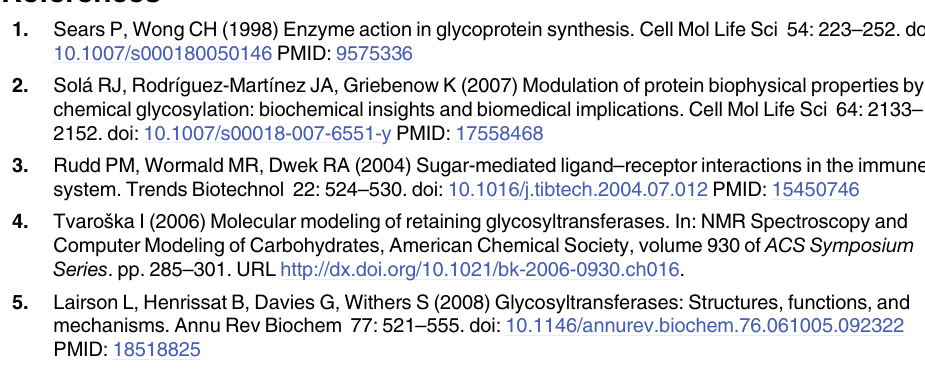
S5 Fig. Raw data points obtained by scanning the two distance-difference coordinates. Twelve outlying points (crossed out) were not used for visualisation of the total energy surface in order to obtain physically meaningful contour lines. S6 Fig. QM and MM energy components of the 2D PES scan surface obtained using dis- tance differences. S7 Fig. QM and MM energy components for the images along the optimized reaction path. Notice the shallow minimum in QM energy around image 9 (expected intermediate), and a corresponding maximum in MM energy in the same region. These two contributions cancel out (for the OPBE functional), leading to no minimum being present on the total energy pro- file. QM energy profile calculated using the Becke-Perdew functional is included, illustrating that this method is unable to produce a physically meaningful description of the reaction. S8 Fig. Evolution of total energy profiles along the NEB path during the course of path op- timisation. Changes between iterations 80 and 100 (final) are negligible, confirming that the path is well-converged. S9 Fig. The conformational itinerary of GalNAc during the reaction. The third quadrant of the pseudorotational diagram constructed from Cremer-Pople ring puckering coordinates is shown. S1 Supporting Information. Complete structures of all (optimised or estimated) stationary points. Two files are provided for each stationary point — a PDB file for the whole system and a XYZ file with only the QM